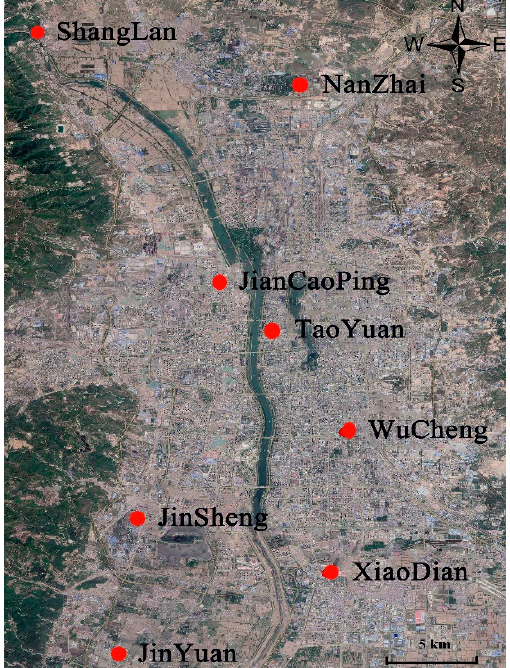
Figure 2. The eight monitoring sites in Taiyuan.